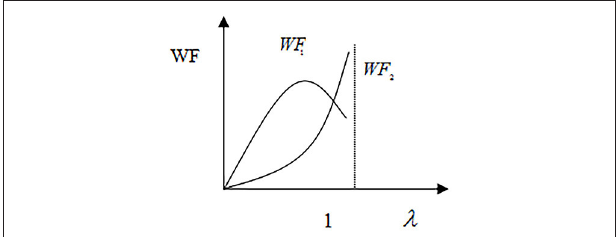
FIGURE 3 | Welfare and co-payment